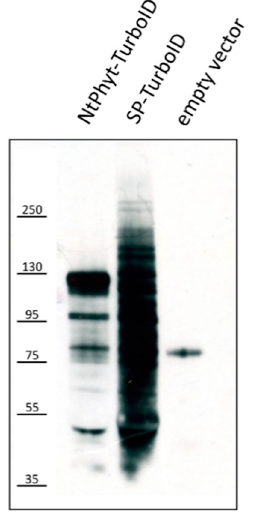
Figure 3. Protein biotinylation in N. benthamiana leaves producing either Nt Phyt ‐ TurboID or SP ‐ TurboID proteins. Western blotting analysis with streptavidin ‐ horseradish peroxidase (HRP) detection of total proteins biotinylated in N. benthamiana leaves producing either Nt Phyt ‐ TurboID or SP ‐ TurboID proteins. ‘Vector,’ total protein sample from leaves infiltrated with agrobacteria carrying the empty vector. Equal amounts of leaf tissues (5 mg) were taken for analysis, and equivalent 15 µ L aliquots of the subcellular fractions were loaded. Positions of molecular weight protein markers are indicated on the left.